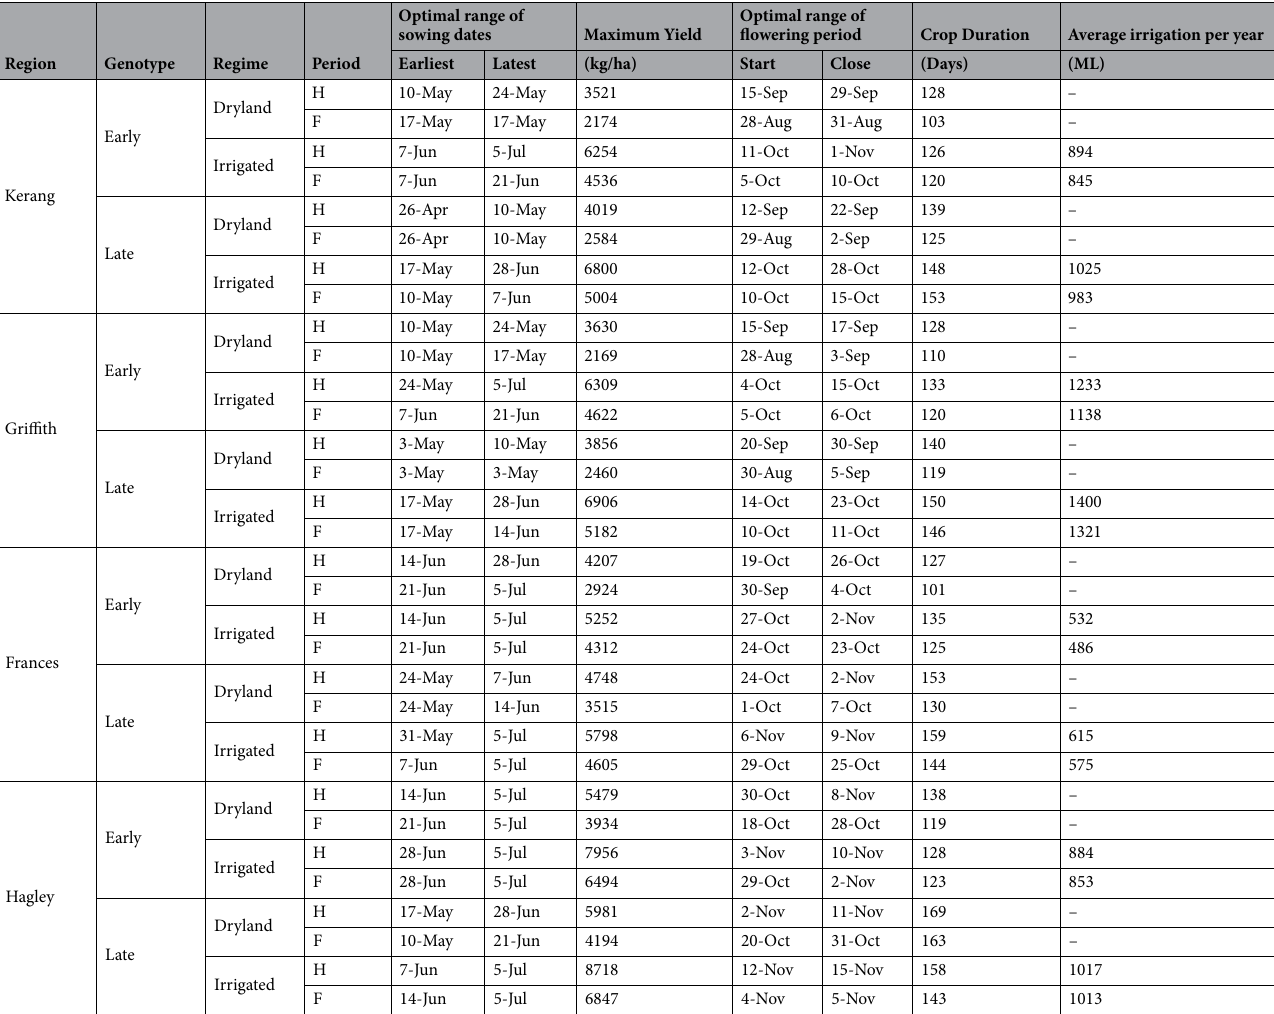
Table 5. Yield, optimal flowering periods and average water applied per annum of irrigated and dryland durum wheat across a range of representative environments in Australian irrigated cropping regions under historical (H = 1985–2004) and future (F = 2070–2089)